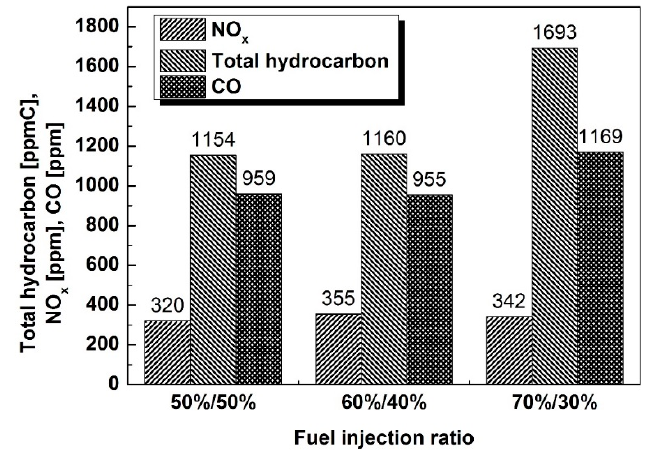
Figure 8. Comparison of NO x , THC, and CO emissions for 50%/50%, 60%/40%, and 70%/30% fuel injection ratios with optimized fuel injection and SA timing at 1600 rpm with BMEP of 0.24 MPa.